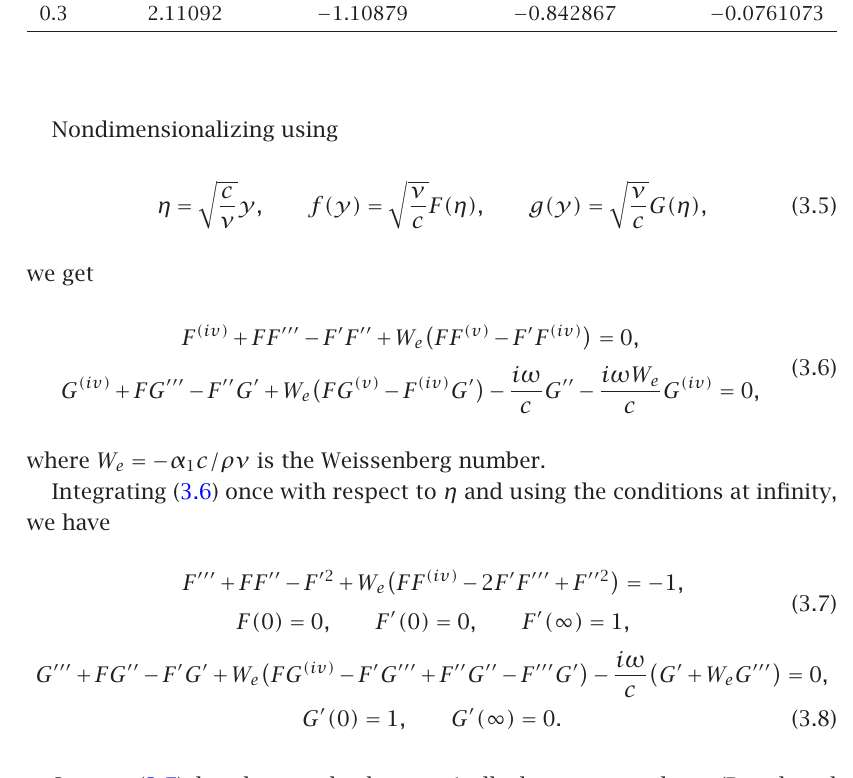
(cid:6) (cid:6) 0 ( 0 ) , φ 1 ( 0 ) , and φ 2 ( 0 ) for